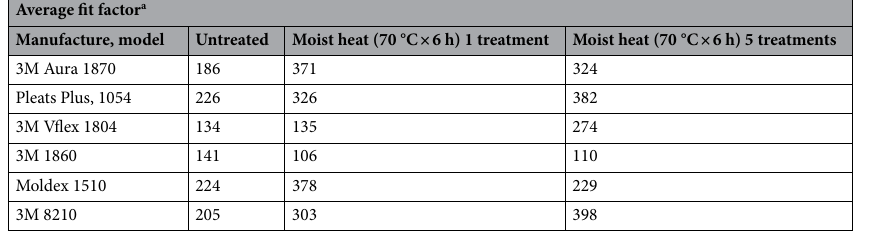
Table 2. Average fit factor before and after moist heat treatments. a A minimum fit factor of 100 is required to pass the test; only one respirator of each type was fit